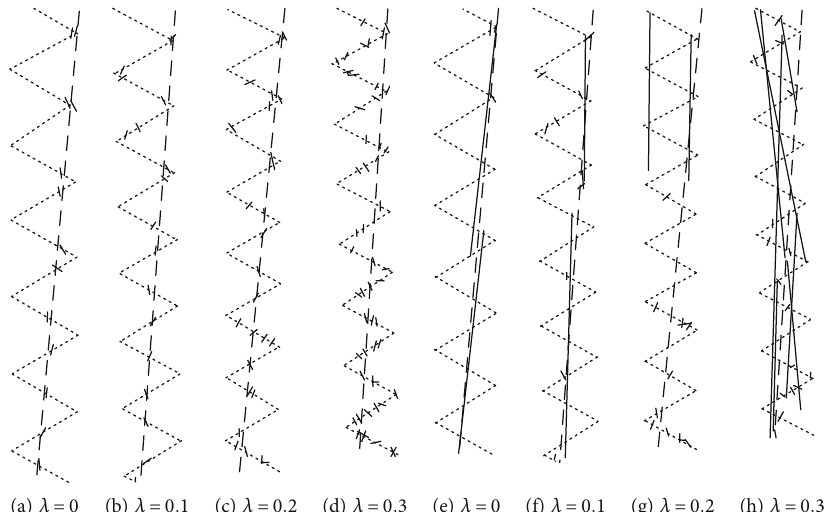
Figure 6: Detection results with only one tested pipeline.